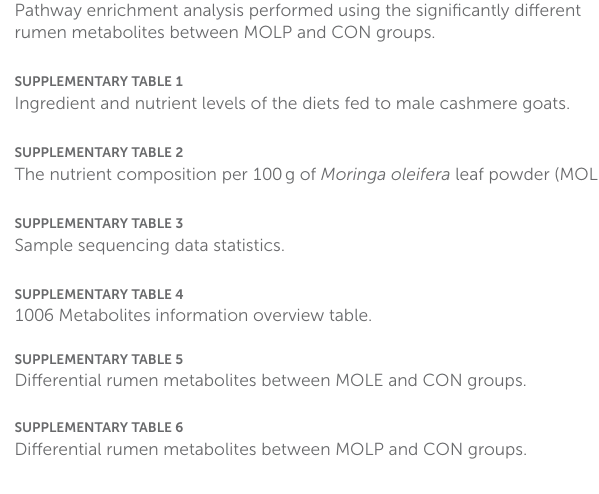
SUPPLEMENTARYFIGURE1 Effects of MOLE and MOLP supplementation on the diversity of rumen microorganisms of cashmere goats. (A) Rarefaction curve. (B) Chao1 index. (C) Shannon index. (D) Venn plot. (E) Microbial clustering based on the Binary-Jaccard distance metric, visualized by principal coordinate analysis. SUPPLEMENTARYFIGURE2 Pathway enrichment analysis performed using the significantly different rumen metabolites between MOLP and CON groups. SUPPLEMENTARYTABLE1 Ingredient and nutrient levels of the diets fed to male cashmere goats.